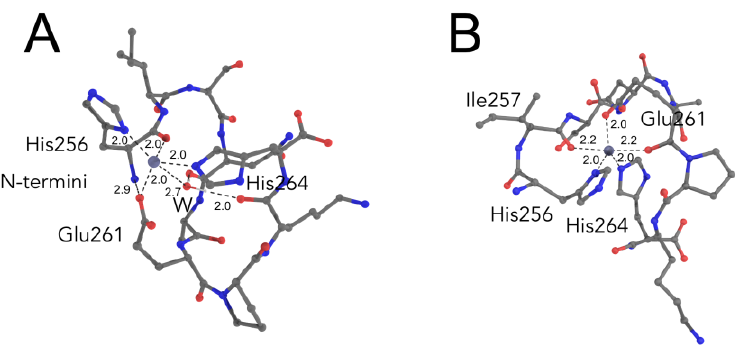
Figure 5. ALR peptide models from QM / MM simulations in which the zinc ion is coordinated ( A ) by four chelators: N δ His256, N δ His264, and O δ Glu261 and backbone O from His256. ( B ) by five chelators: N δ His256, N δ His264, O δ Glu261, backbone O from Glu261, and backbone O from Ile257. Oxygen atoms colored in red, nitrogen atoms in blue, carbon atoms in grey, and zinc cation in slate blue. Dashed lines present distances in the coordination sphere. Atom names are given according to the IUPAC-IUB